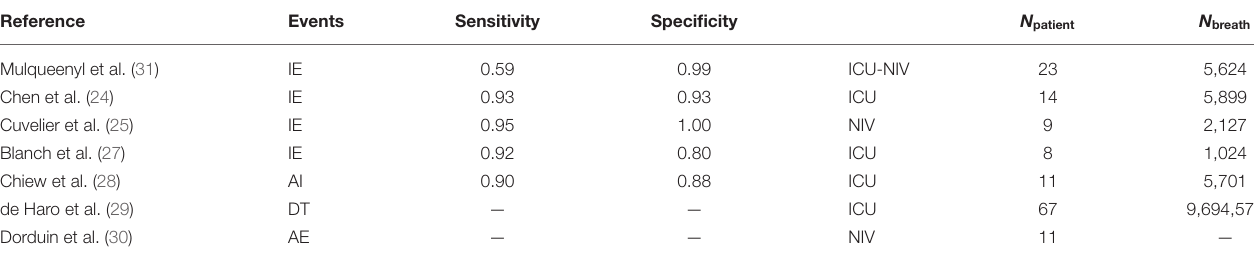
TABLE 5 | Brief overview of the studies devoted to automatic scoring of AE in mechanical ventilation.